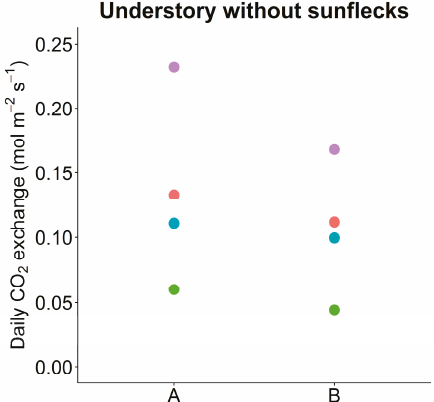
Figure 12. Simulated daily carbon gain without sunflecks on the sunny day (3 July 2020), in which sunflecks ( > 200 μ mol m − 2 s − 1 ) were replaced by the fixed value 200 μ mol m − 2 s − 1 . A: Net daily photosynthesis calculated with actual leaves in the understory. B: Net daily photosynthesis when the leaves were hypothetically changed to the clearing leaves. The same leaf simulated under the two di ff erent scenarios appears as the same